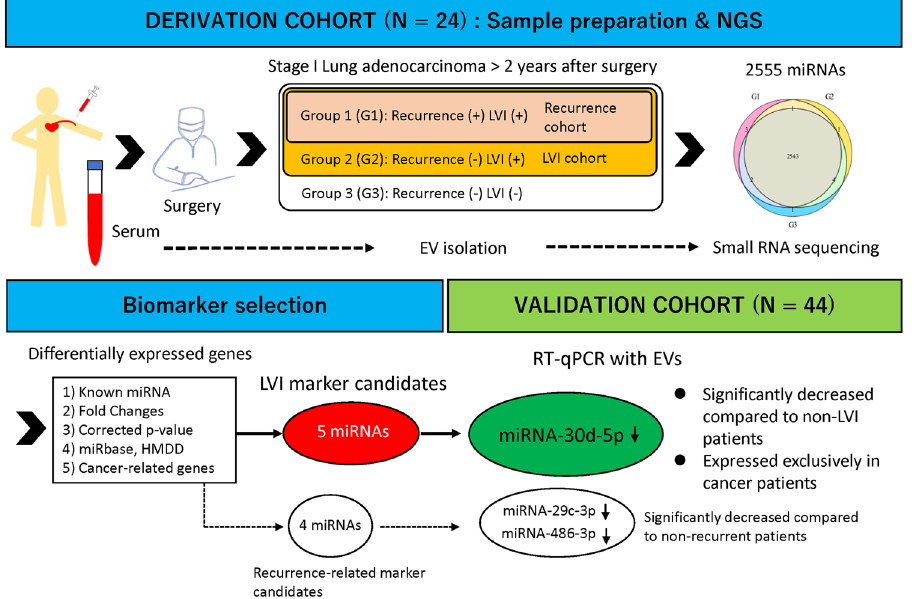
Figure 1. Schematic overview of the strategy used to identify extracellular vesicle-associated microRNA (miRNA) signature associated with vascular invasion and postoperative recurrence. NGS nest generation sequencing, LVI vascular invasion, EV extracellular vesicle, miRNAs microRNAs, RT-qPCR reverse transcription-quantitative polymerase chain